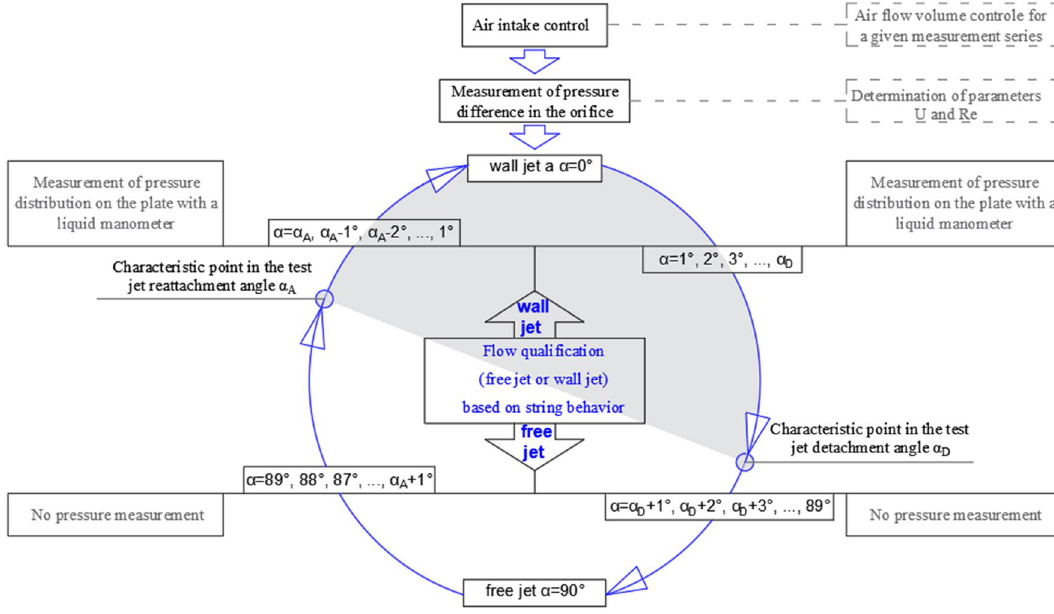
Figure 3. Flow chart presenting successive research tasks in the process of experimental